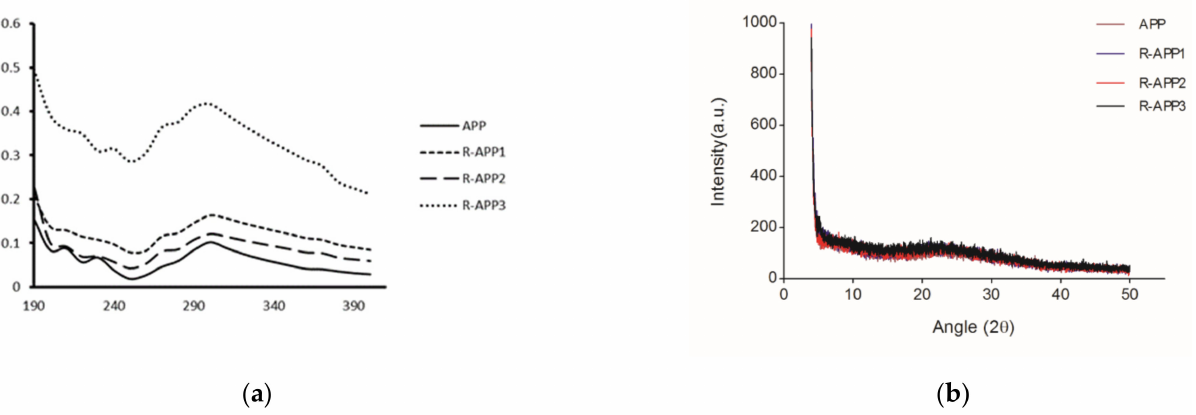
Figure 5. UV–Vis spectra and the X-ray diffraction pattern of native APP and irradiated APP at doses of 10 kGy (R-APP1), 100 kGy (R-APP2), and 1000 kGy (R-APP3). ( a ) UV–Vis spectra; ( b ) X-ray diffraction